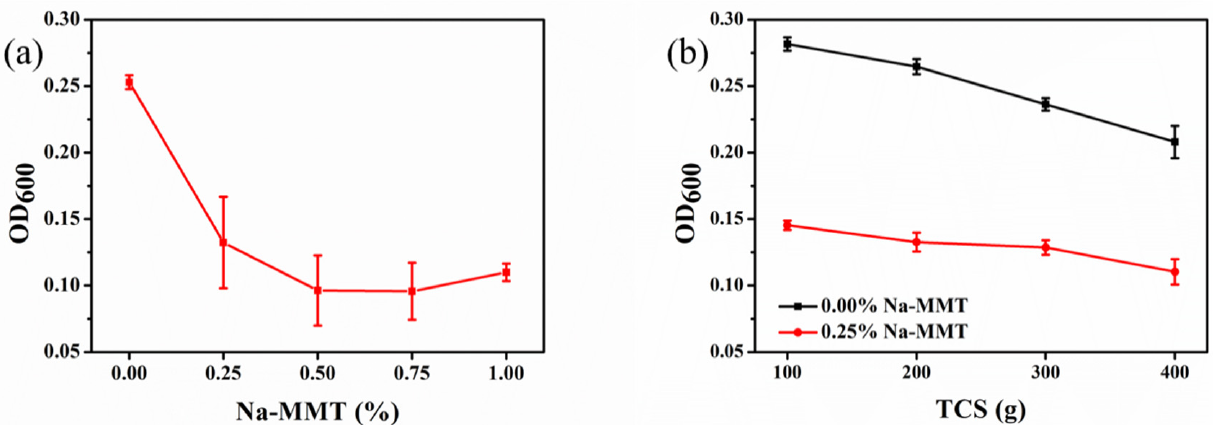
Figure 3. OD 600 of bacteria with various Na-MMT concentrations ( a ) and TCS quantities in the absence of and in the presence of 0.25% Na-MMT ( b ).